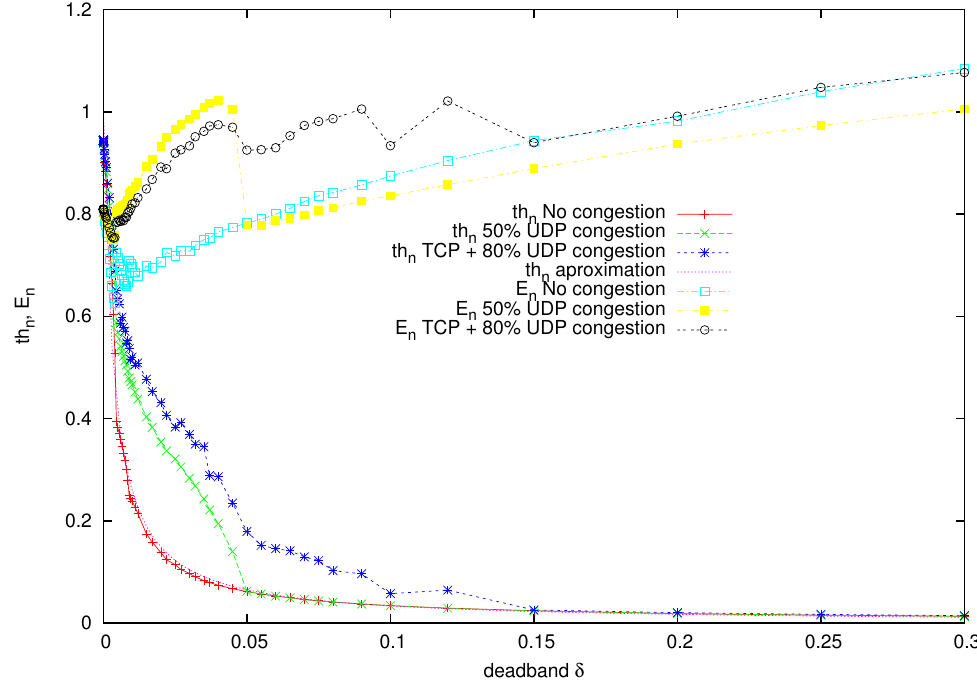
) and average error ( E n